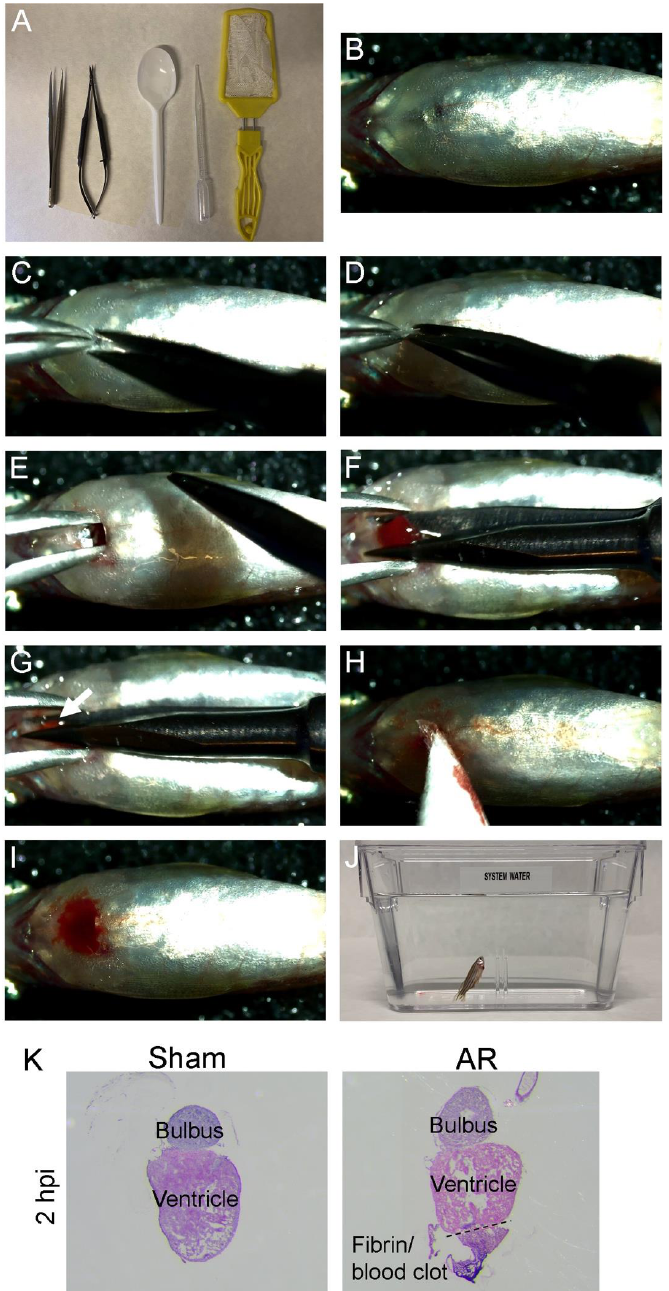
Figure 2. Surgical procedure for sham operation and apex resection (AR). ( A ) Instruments and utensils required for AR and sham surgery in zebrafish, details are specified in materials and methods. ( B – J ) Pictures demonstrating each major step in AR surgery (See Supplementary Video S2 for AR and Supplementary Video S3 for sham surgery). ( B ) Locating the beating heart. ( C ) Use the forceps to gently lift up the skin. ( D ) With the micro scissors make a small incision just above the heart. ( E ) Widen the incision with the forceps. ( F ) Gently applied pressure on the sides of the incision will make the heart “pop out”. ( G ) 10–20% of the apex is resected, white arrow marks the resected piece. ( H ) Remove the instruments and let the heart get back in place before wiping away the blood. ( I ) The wound after the procedure. ( J ) The recovering zebrafish (See Supplementary Video S4 for details regarding recovery). ( K ) Haematoxylin and eosin (HE) stained section from sham and AR hearts 2 h post injury (hpi) showing the heart and where the bulbus should be located as well as the fibrin/blood clot at the resection site. Scalebar: K = 300 µ